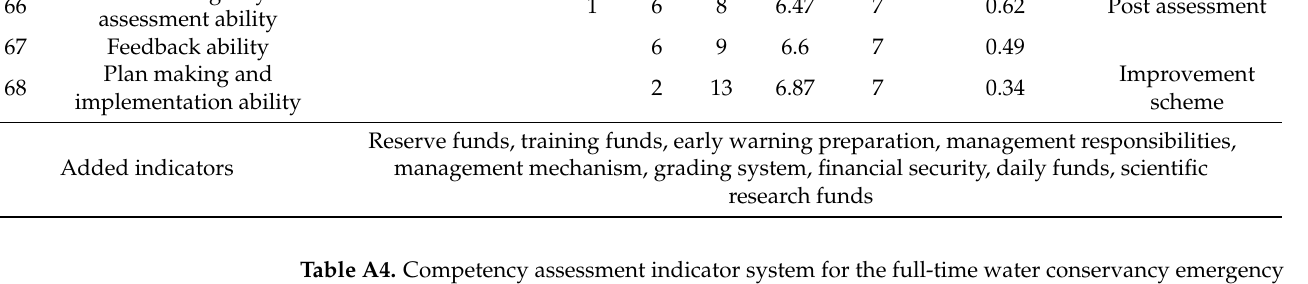
Table A4. Competency assessment indicator system for the full-time water conservancy emergency rescue